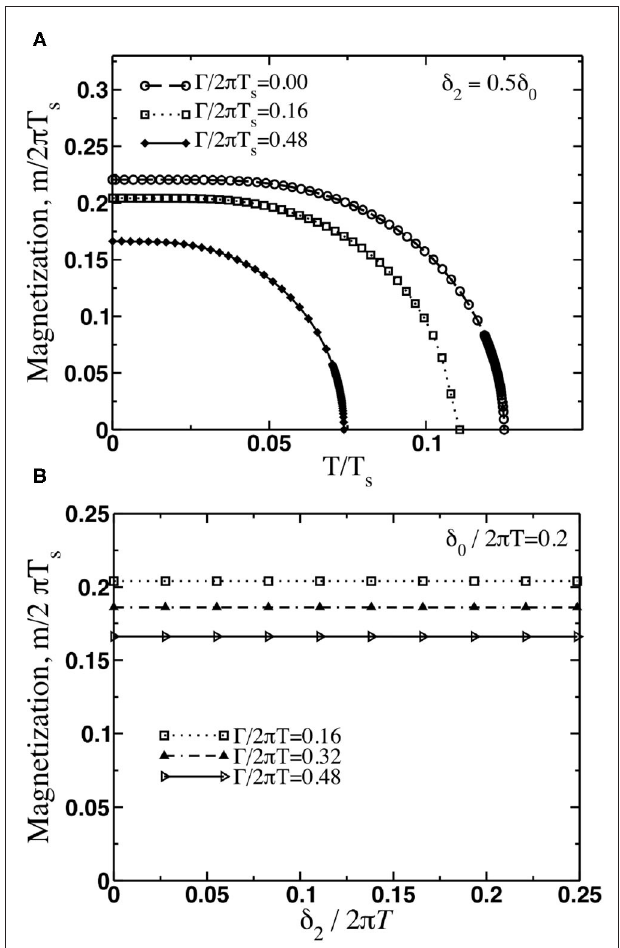
FIGURE 1 | Dependence of magnetizations m 1 and m 2 on temperature and anisotropy parameter δ 2 obtained by the numerical analysis of the self-consistency equations (18). Within the numerical accuracy, we found that m 1 m 2 . (A) Magnetization as a function of temperature are plotted for = various values of scattering rate Ŵ and δ 2 a Curie temperature in isotropic system without impurities. (B) Magnetization as a function of the Fermi surface anisotropy parameter δ 2 and T